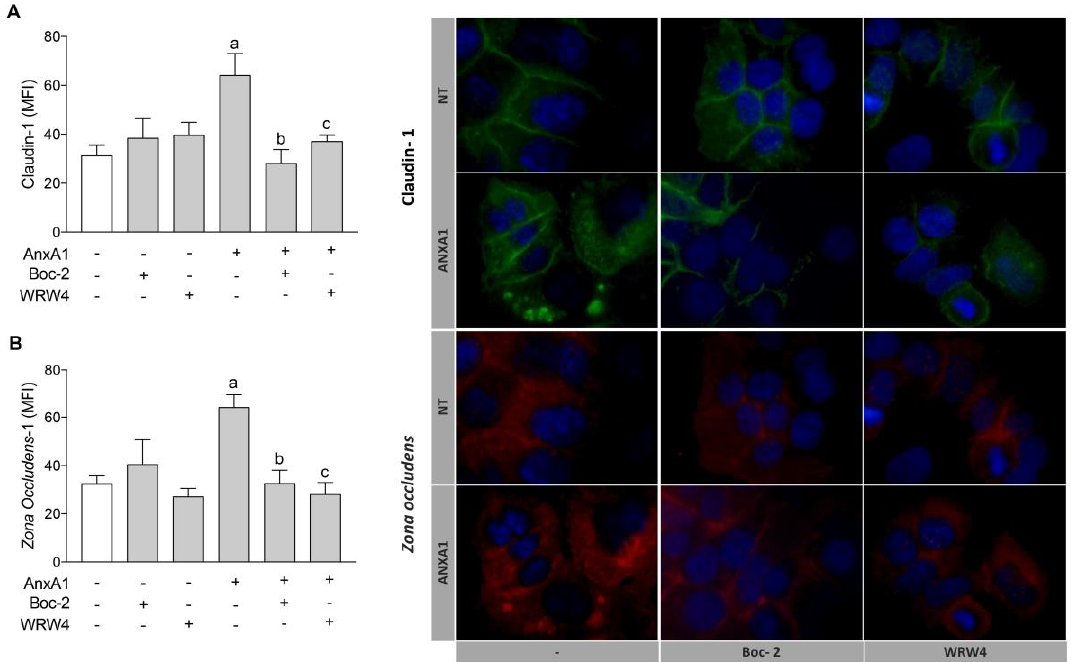
Figure 3. AnxA1 controlled claudin-1 and ZO-1 expressions on uterine epithelial cells via FPR1 and FPR2. Claudin-1 ( A ) and ZO-1 ( B ) expressions on uterine epithelial cells were determined 24 h after incubations. Representative images of claudin-1 and ZO-1 immunofluorescence are shown. ( − ) means absence and ( + ) means presence of treatments. The data are expressed as mean ± standard error of mean of three to five independent experiments. a p < 0.05 vs. NT; b p < 0.01 and c p < 0.05 vs. AnxA1.